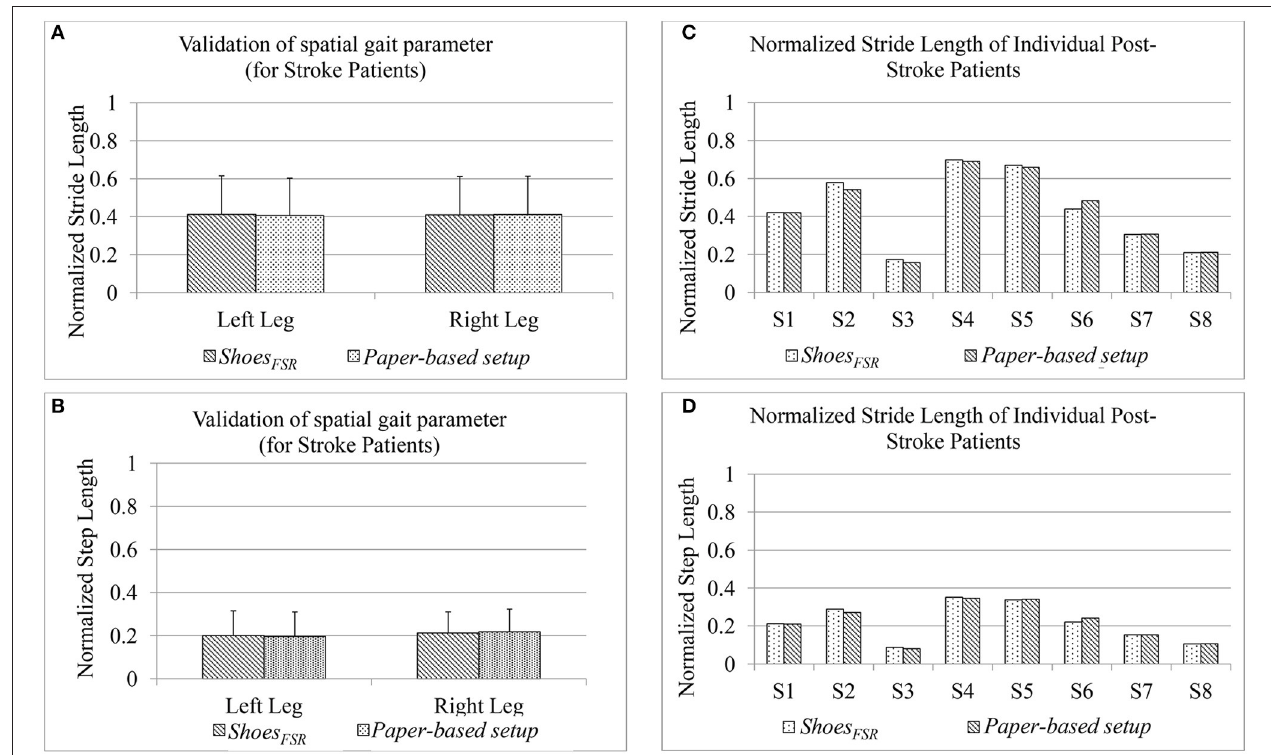
FIGURE 8 | Comparison of normalized (A) Stride Length and (B) Step Length measured using Shoes FSR and paper-based setup for post-stroke hemiplegic patients (C) Normalized Stride Length of individual post-stroke patients (D) Normalized Step Length of individual post-stroke patients. patients, as evident from post-study video analysis. Also, this